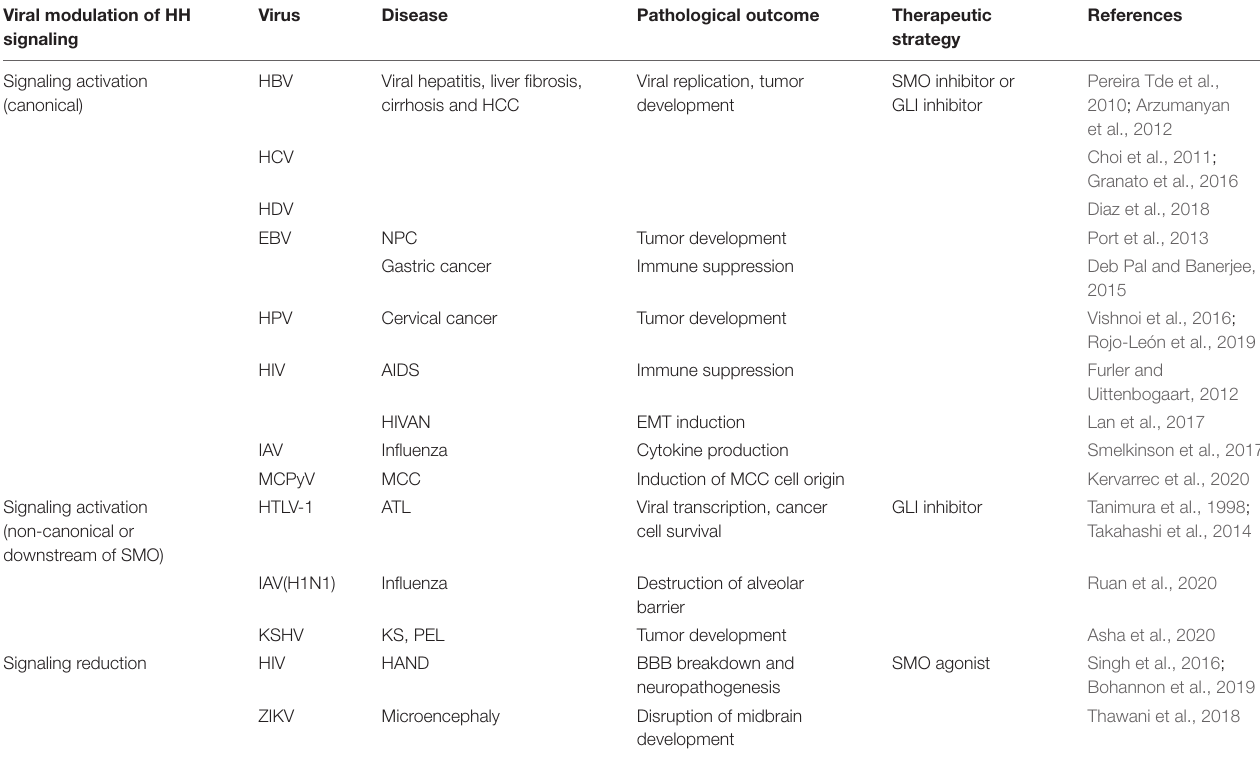
TABLE 1 | The pathological role of hedgehog signaling in viral infections and the potential therapeutic